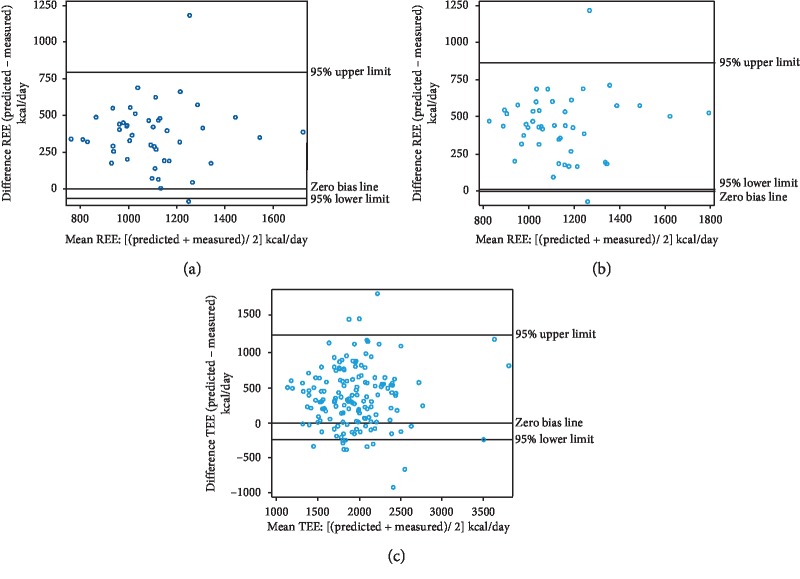
Bland–Altman comparative analysis for predicted energy expenditure (according to the Harris–Benedict, Schoenfeld, and K/DOQI-recommended equations) against measured energy expenditure (measured using indirect calorimetry) in HD patients. REE: resting energy expenditure and TEE: total energy expenditure.(a). Harris–Benedict Equation. (b). Schoenfeld Equation (c). K/DOQI Equation.